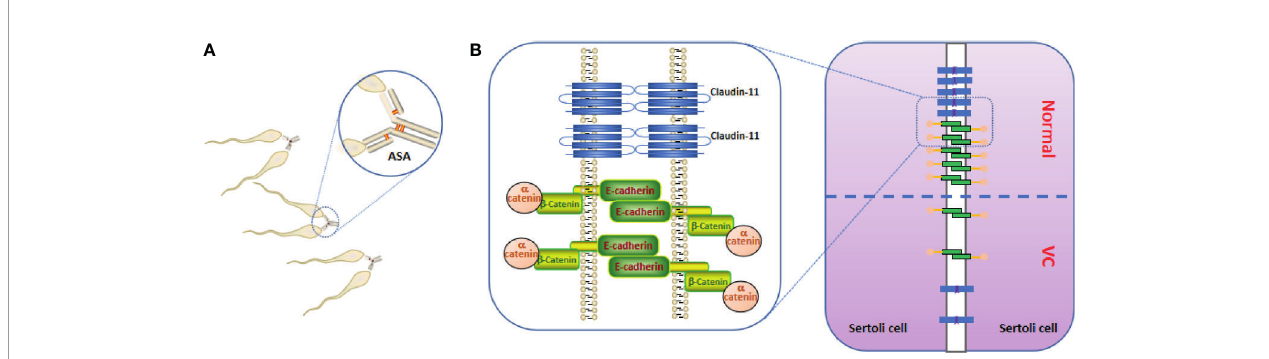
FIGURE 1 | Anti-sperm antibodies (ASAs) and blood testes barrier (BTB). (A) ASAs bind to sperm, resulting in sperm agglutination and sperm motility reducing. (B) the important constituent proteins (claudin-11, E-cadherin, and a -catenin) that constitute the BTB are reduced in the testes of Varicocele (VC), resulting in increased BTB